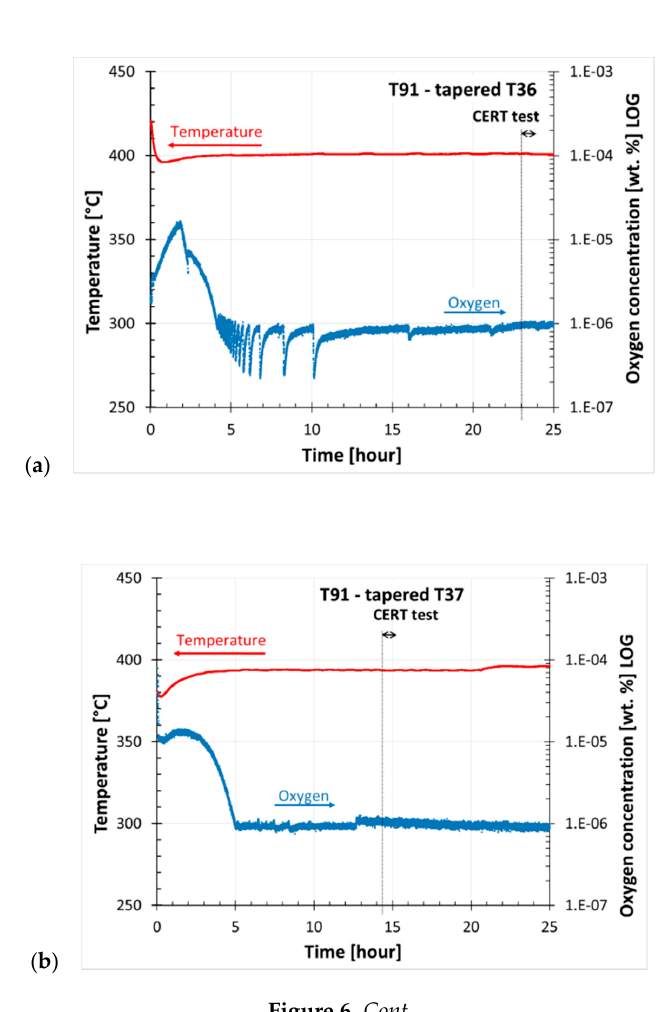
Figure 5. Test results of constant extension rate tensile (CERT) tests of tapered specimens in air and in liquid Pb at 400 °C.